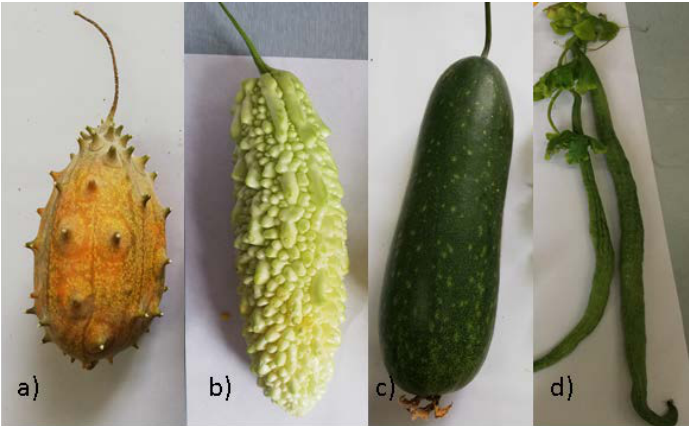
Figure 1. Romanian plant varieties: ( a ) Cucumis metuliferus ” Tempus” variety , ( b ) Momordica charantia ” Brâncuși” variety, ( c ) Benincasa hispida ” Zefir” variety and ( d ) Trichosanthes cucumerina ” Felix” variety.